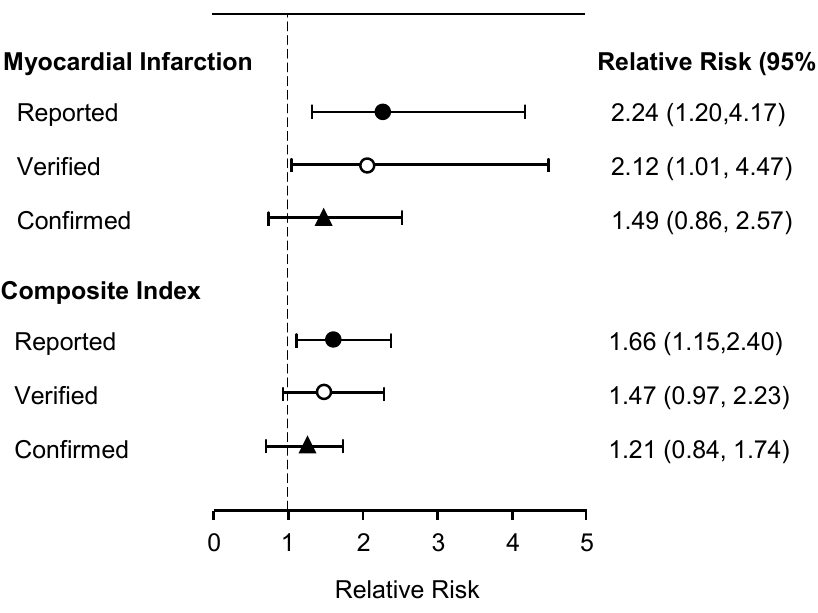
Figure 1. Summary of the relative risk for myocardial infarction (MI) and the